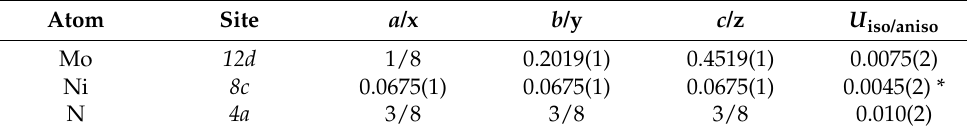
Table 2. Position and displacement parameters for Mo 3 Ni 2 N.